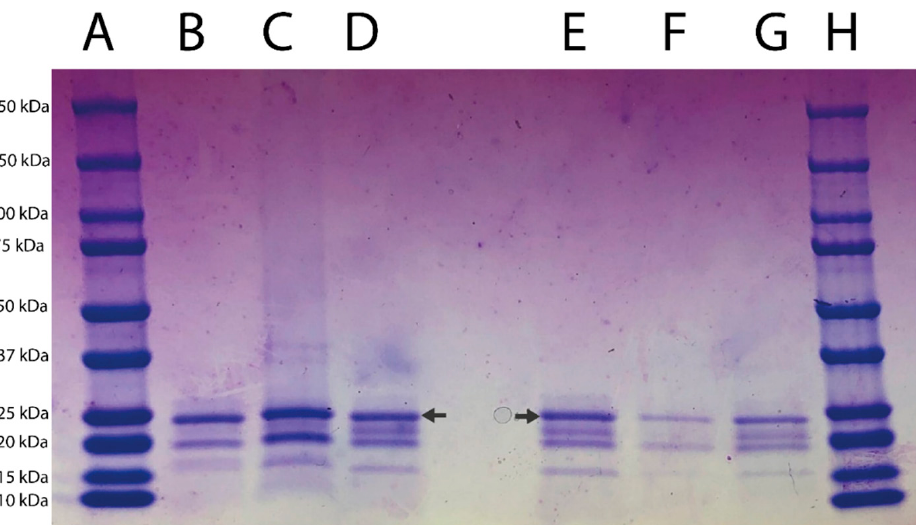
Figure 1. SDS-PAGE patterns of aqueous extract of ripe and unripe kiwifruits. Lanes A, H: molecular markers; lane B: ripe fruit pulp; lane C: ripe fruit peel; lane D: ripe whole fruit; lane E: unripe fruit pulp; lane F: unripe fruit peel; lane G: whole unripe fruit. The arrows indicate actinidin bands corresponding to approximately 23 kDa.